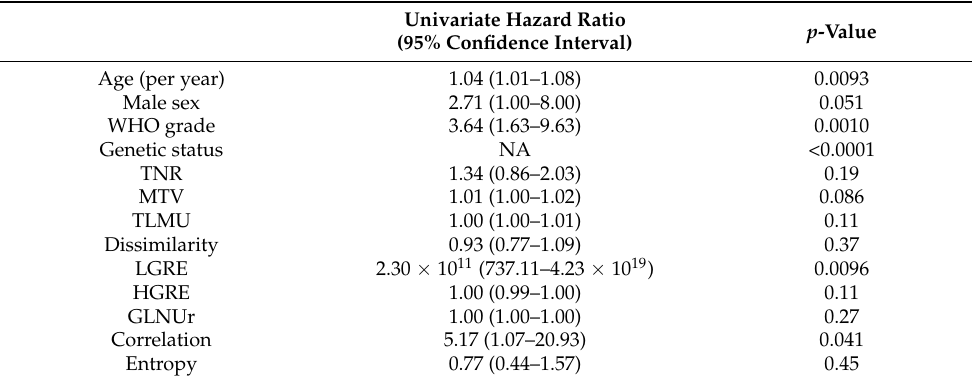
Table 3. Univariate analyses of factors associated with all-cause death.